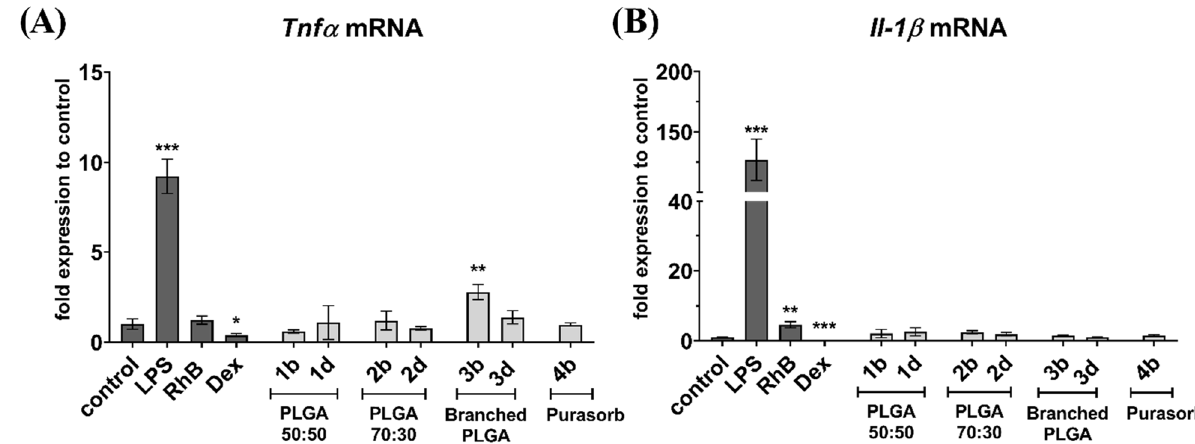
Figure 4. Real-time RT-qPCR quantification of ( A ) Tnf α mRNA and ( B ) Il-1 β mRNA in bone marrow-derived macrophages. Cells were incubated with nanospheres for 24 h. Results were compared with untreated cells (control), cells treated with lipopolysaccharide in concentration 100 ng/mL (LPS) to stimulate proinflammatory cytokines expression, dexamethasone solution in a concentration of 200 nM/mL (DEX) and RhB solution in concentration 15 µ g/mL (RhB). Data are presented as a fold change in expression relative to untreated control cells (set to be 1). Figure shows a representative experiment data. * p < 0.05, ** p < 0.01, *** p <